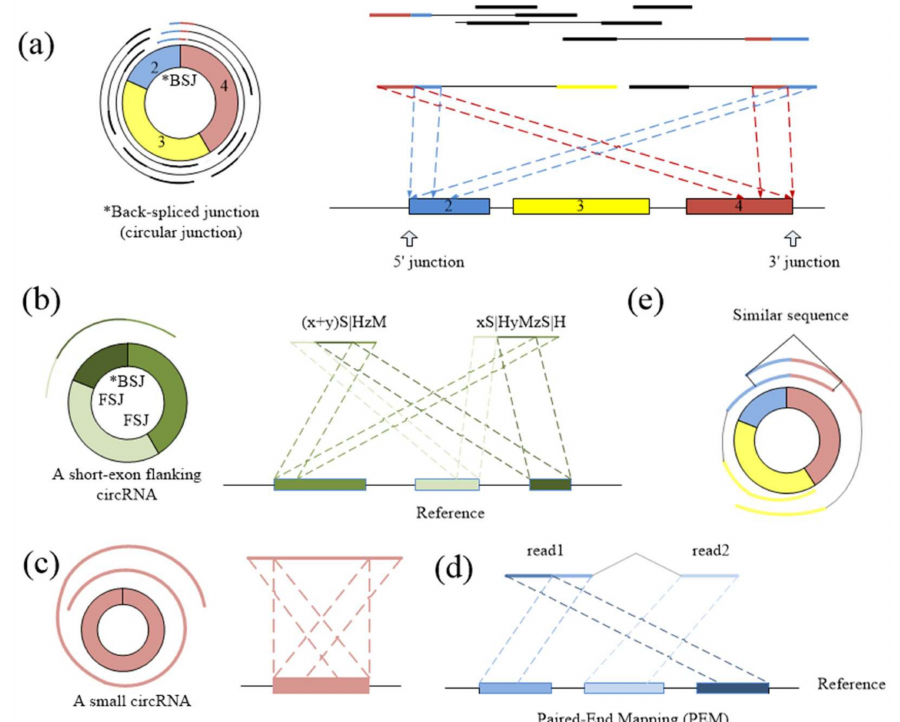
Figure 5. ( a ) The typical two-segment junction reads align to the reference genome separately in reverse orientation. ( b ) If one exon flanking the junction is shorter than the read length, the rest of the segment can be aligned to the nearby exon(s) contained in the circRNA. ( c ) If the length of a circRNA is shorter than the read length, it may map to the reference genome in another three-segment style. ( d ) The pair read of a junction read should align within the inferred circRNA area. ( e ) Any two of BSJ reads within a circRNA should have a similar sequence. The dotted lines suggest the possible alignment of each part of BSJ